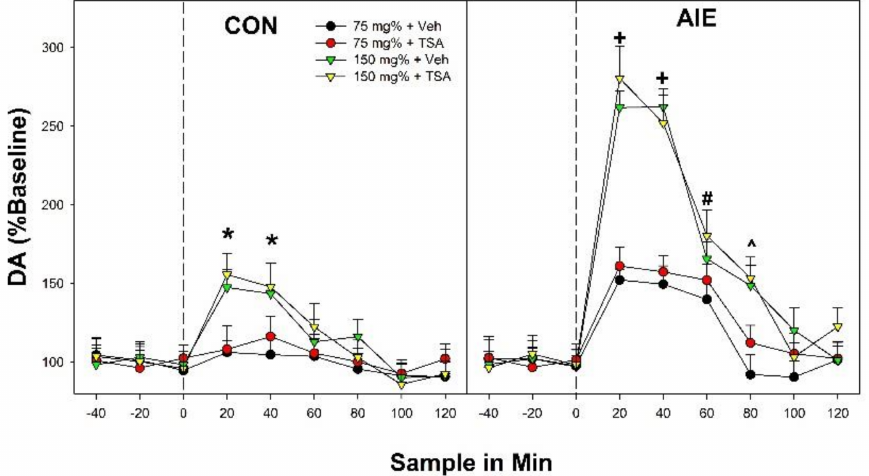
Figure 5. Dopamine levels (%Baseline) in the AcbSh following microinjections of EtOH into the poste- rior VTA in male Wistar rats that received water treatment (CON; left panel) or binge-EtOH exposure during adolescence (AIE; right panel) following pretreatment/treatment with the HDAC inhibitor Trichostatin A (TSA). TSA failed to alter any measure. * indicates that in CON rats, the 150 mg%-Veh and 150 mg%-TSA groups had significantly higher levels of DA in the AcbSh than 75 mg%-Veh and 75 mg% TSA groups. + indicates that in AIE rats 150 mg%-Veh and 150 mg%-TSA > 75 mg%-Veh and 75 mg%-TSA (all AIE groups different from CON groups). # indicates that all AIE rats (both Veh and TSA) are significantly different from CON groups. ˆ indicates that in AIE rats 150 mg%-Veh and 150 mg%-TSA groups are different from all other groups. Data are mean ±